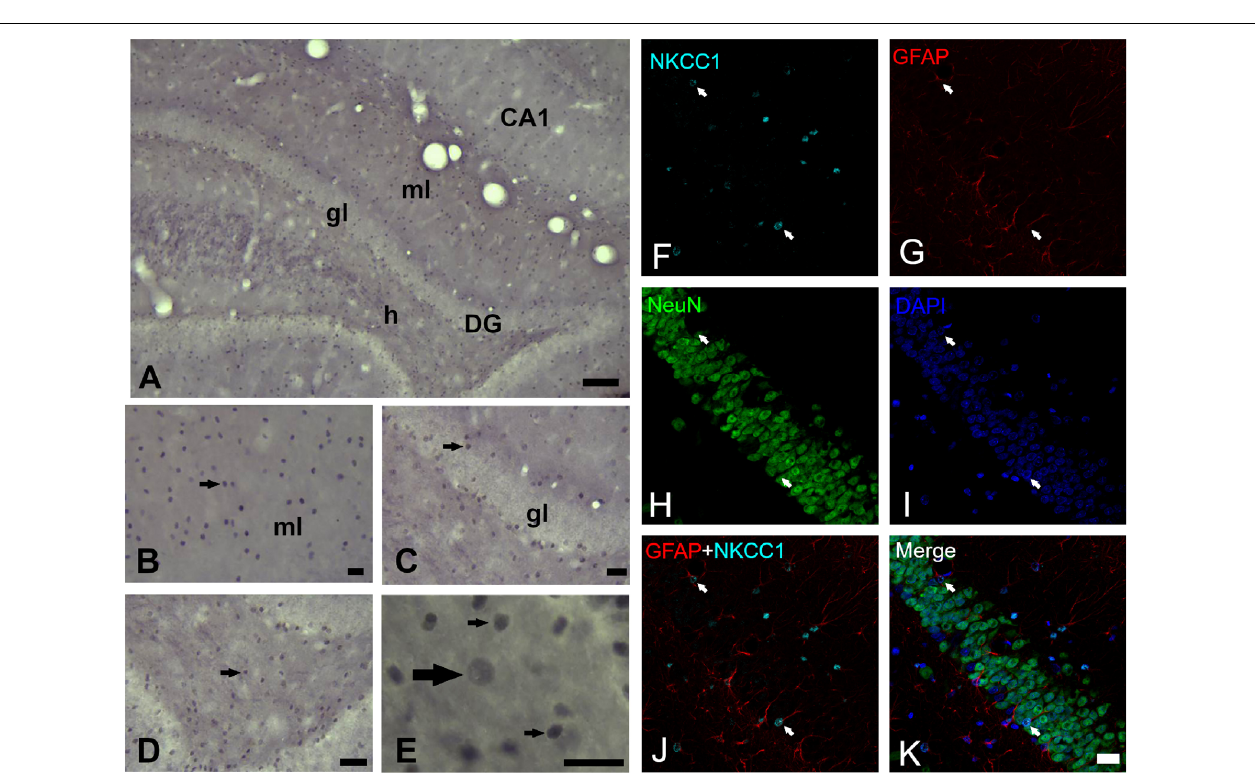
FIGURE 2 | NKCC1 expression in dentate gyrus of rats fed with a normal diet. (A) NKCC1-IR cells in the molecular (ml) and granule (gl) layer and hilus (h) of dentate gyrus ( − 3.3 mm posterior to Bregma). (B–E) NKCC1-IR cells (arrows) were found distributed through all dentate gyrus. (E) Higher magnification of hilus, NKCC1 immunostaining showed predominantly small, abundant and intensely stained cells, presumptive glial cells (thin arrows) and some scarce, large and weakly stained cells, presumptive neuronal cells (thick arrow). Quadruple immunofluorescence labeling of NKCC1 with NeuN (a neuron-specific marker), GFAP (a marker for astrocytes) and DAPI (a marker for nuclei) (F–K) . NKCC1-IR cells were mainly astrocyte-type glial cells, abundant, small and intensely stained cells (arrows indicate on all panels, NKCC1 and GFAP immunopositive astrocytes, except in NeuN panel where arrows indicate their absence). Scale bar: 100 µ m (A) , 25 µ m (B–D) , 10 µ m (E) and 20 µ m (F–K)